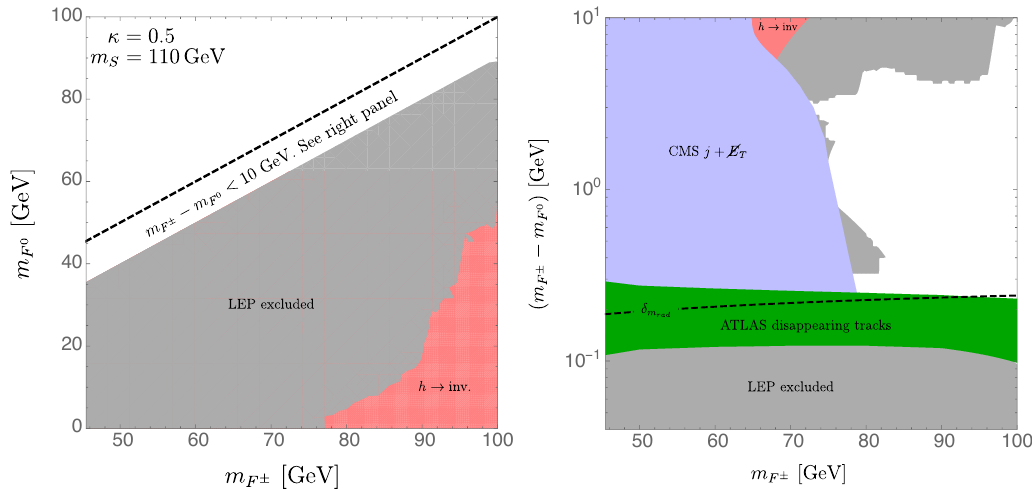
Figure 10 . Limits on charginos F (cid:6) (from the simpli(cid:12)ed model of section 3), set by LEP and by the LHC, in the uncompressed region (left) and in the compressed region (right). The coupling is set to (cid:20) = 0 : 5 and the scalar singlet mass to m S = 110 GeV. The LEP limits are the same as in (cid:12)gure 9 but here are indicated in gray, while LHC limits are colored. In the uncompressed region, the strongest limits are obtained from LEP and from LHC constraints on invisible Higgs decays. In the compressed region, the strongest limits are obtained from LEP and from LHC monojet and disappearing track searches. The black dashed line indicates the one-loop radiative charged-neutral mass splitting.